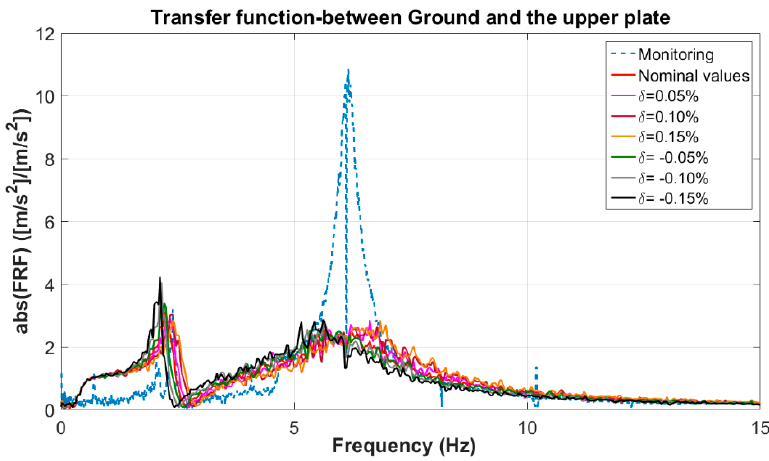
Figure 19. Transfer function between the ground plate and the upper plate with TMDIs in the presence of various percentages of uncertainties in the damping and stiffness matrices of the structure ( δ = δ C = δ K ).